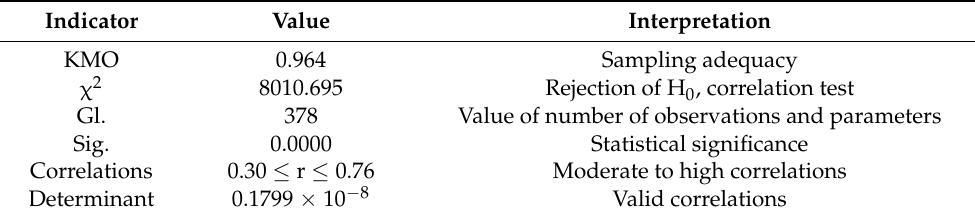
Table 5. Preliminary factorial results of ethical values in